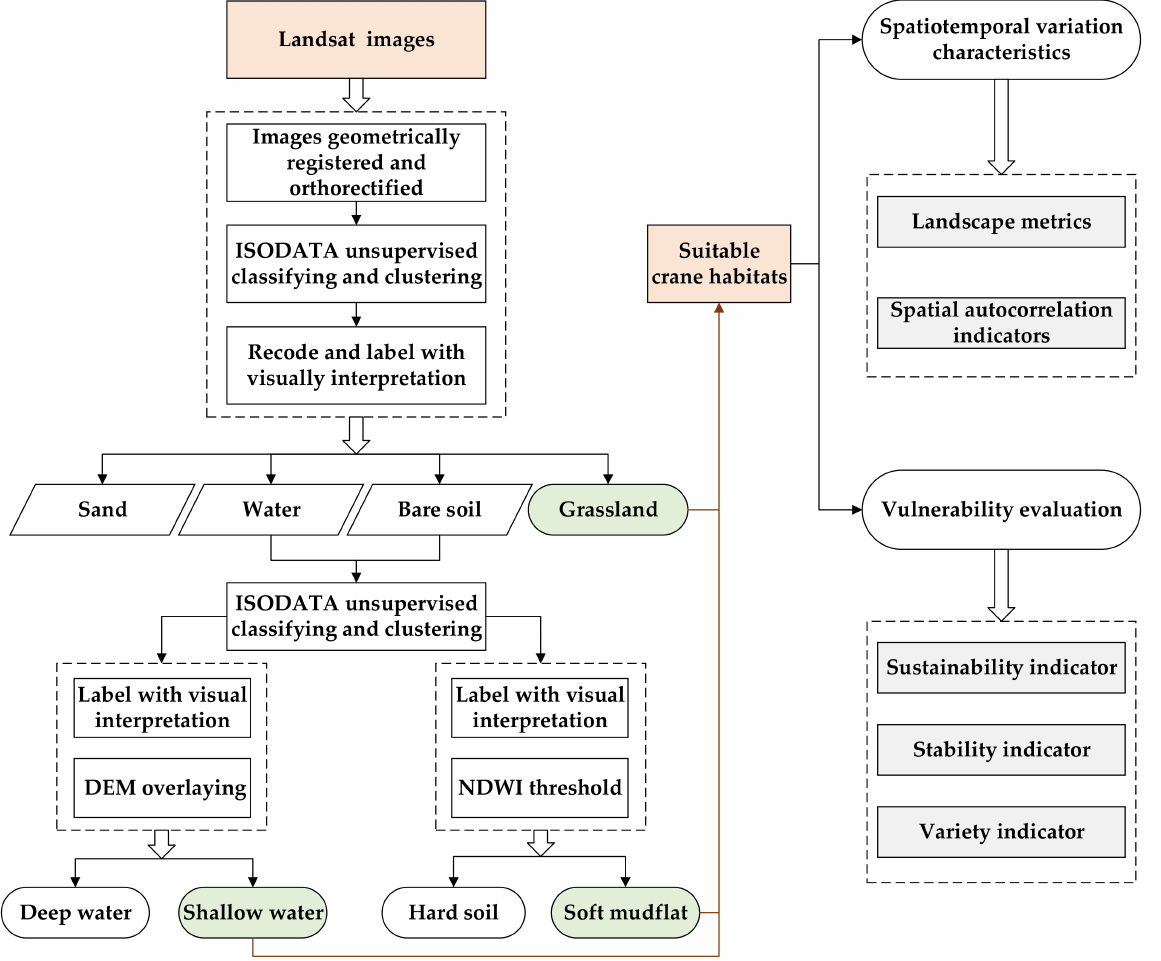
Figure 2. Research design flowchart of the Poyang Lake wetland landscape classification (left part) and the analyses of the spatiotemporal variation of Siberian crane habitats (right